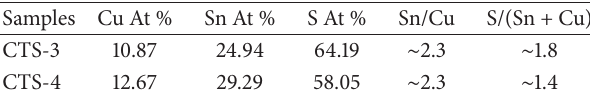
SnS thin films. 2 3